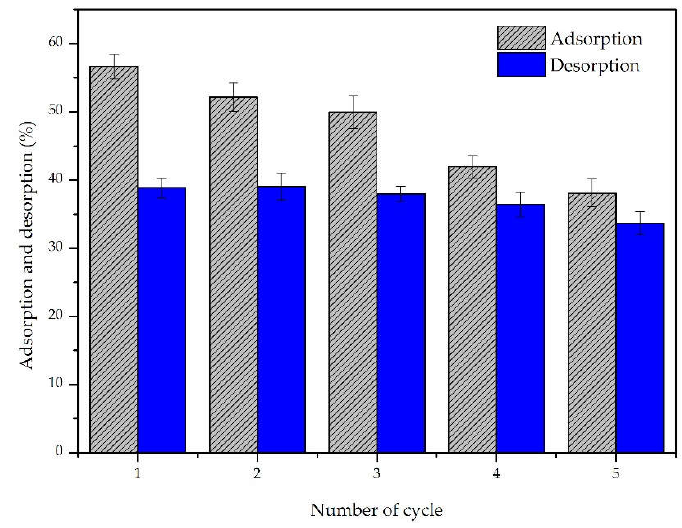
Figure 12. Regeneration of modified zeolite.